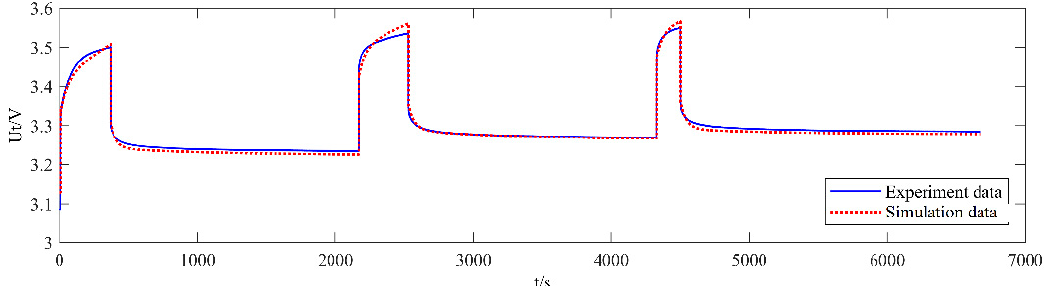
Figure 6. Comparison of 20 A variable current charging experiment results and battery model simulation results.